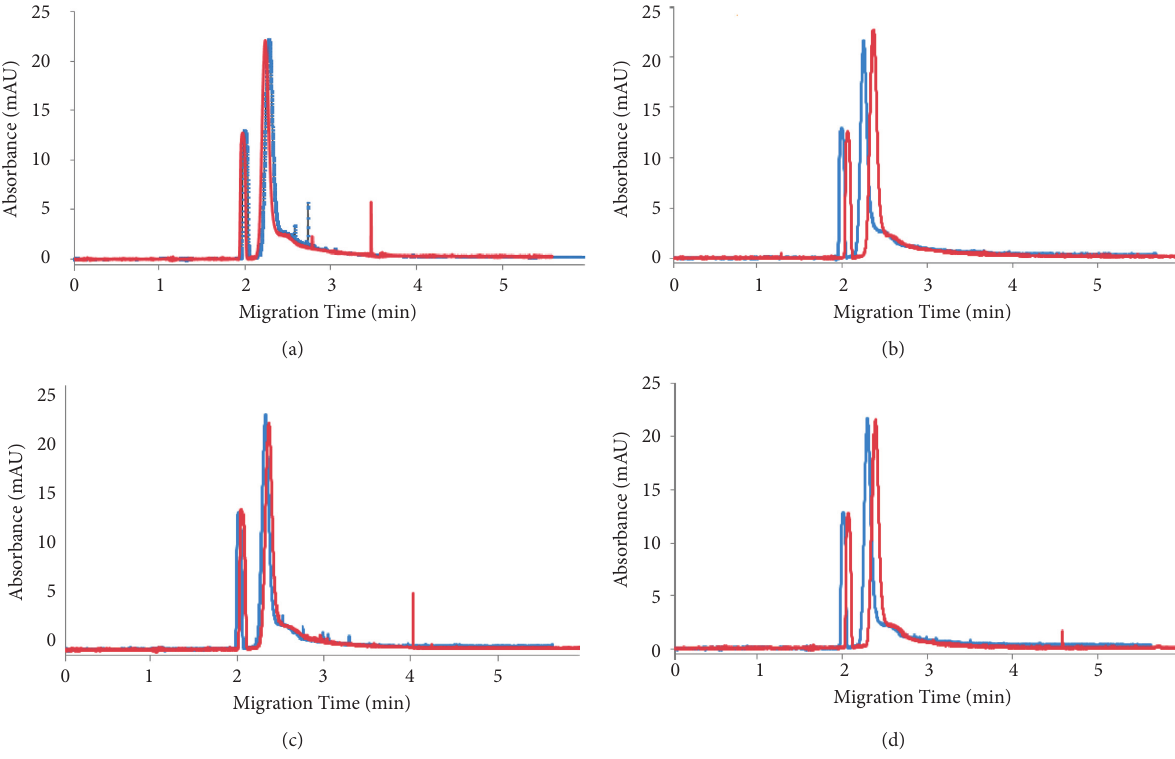
Figure 2: Representative electropherograms showing the change in the electrophoretic mobility (migration time) of transferrin and apotransferrin after iron (III) ion interaction. The first peak is due to acetanilide (EOF marker) and the second peak belongs to the protein analyte. (a) Blue line: transferrin without Fe 3+ ; red line : transferrin with Fe 3+ at 50 μ mol/L iron (III) ion concentration. (b) Blue line : transferrin without Fe 3+ ; red line: transferrin with Fe 3+ at 100 μ mol/L concentration. (c) Blue line: apotransferrin without Fe 3+ ; red line : apotransferrin with Fe 3+ at 50 μ mol/L iron (III) ion concentration. (d) Blue line : apotransferrin without Fe 3+ ; red line: apotransferrin with Fe 3+ at 100 μ mol/L concentration.